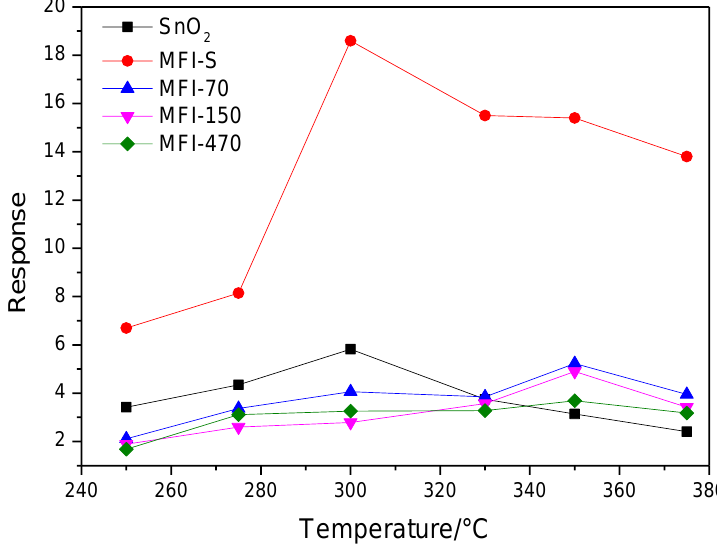
Figure 5. Relationships between sensors response and operating temperature.